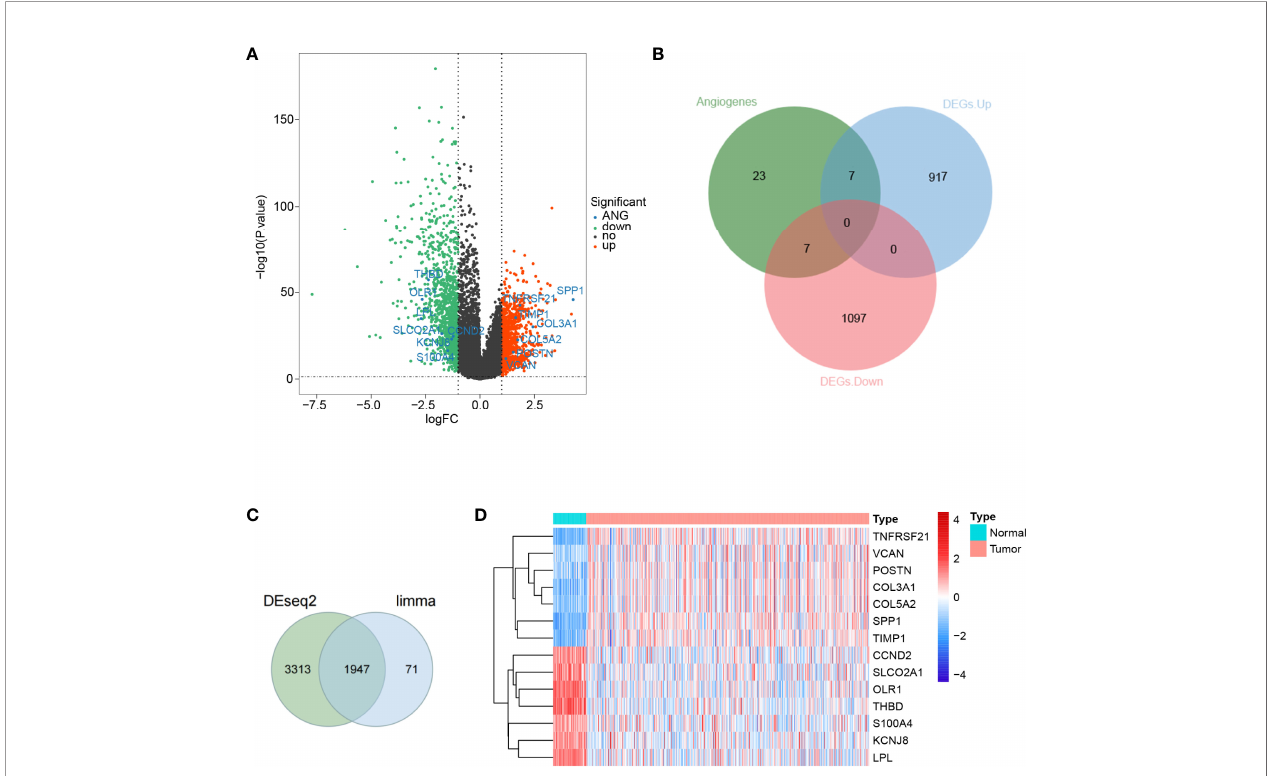
FIGURE 1 | Differential expression of angiogenesis-related genes in lung adenocarcinoma. (A) A volcano map of gene differential expression in lung adenocarcinoma and normal lung tissue samples. The abscissa represents log 2 FC and the ordinate represents -log 10 ( P -value). Each dot represents a gene, and the red dots represent upregulated differentially expressed genes. The green dots represent downregulated differentially expressed genes, while the black dots represent no signi fi cant differences. The horizontal reference line represents p -value = -log 10 (0.05), and the vertical reference line represents log 2 FC = ± 1. (B) Fourteen angiogenic-related genes were screened, of which 7 were upregulated and another 7 were downregulated. (C) Limma and Deseq2methods for gene calculations. In total, 96% of the differentially expressed genes calculated by Limma overlapped withDeseq2. (D) A total of 14 angiogenic differential gene expression heat